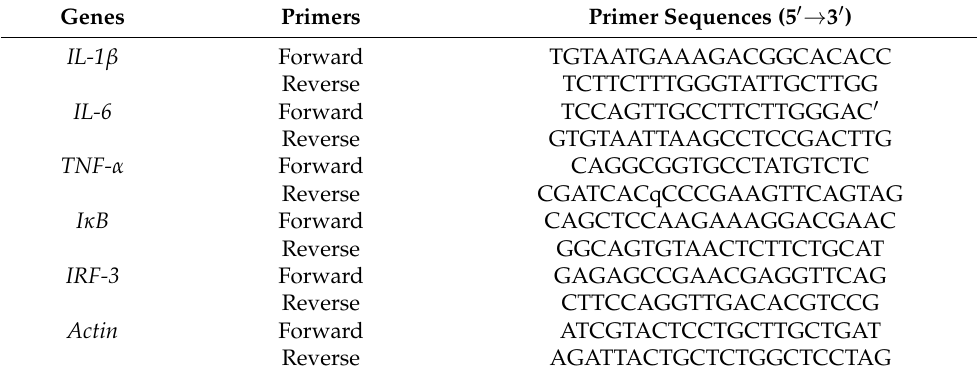
Table 1. Primers used for qRT-PCR assays. Genes Primers Primer Sequences (5 (cid:48) → 3 (cid:48) ) IL-1